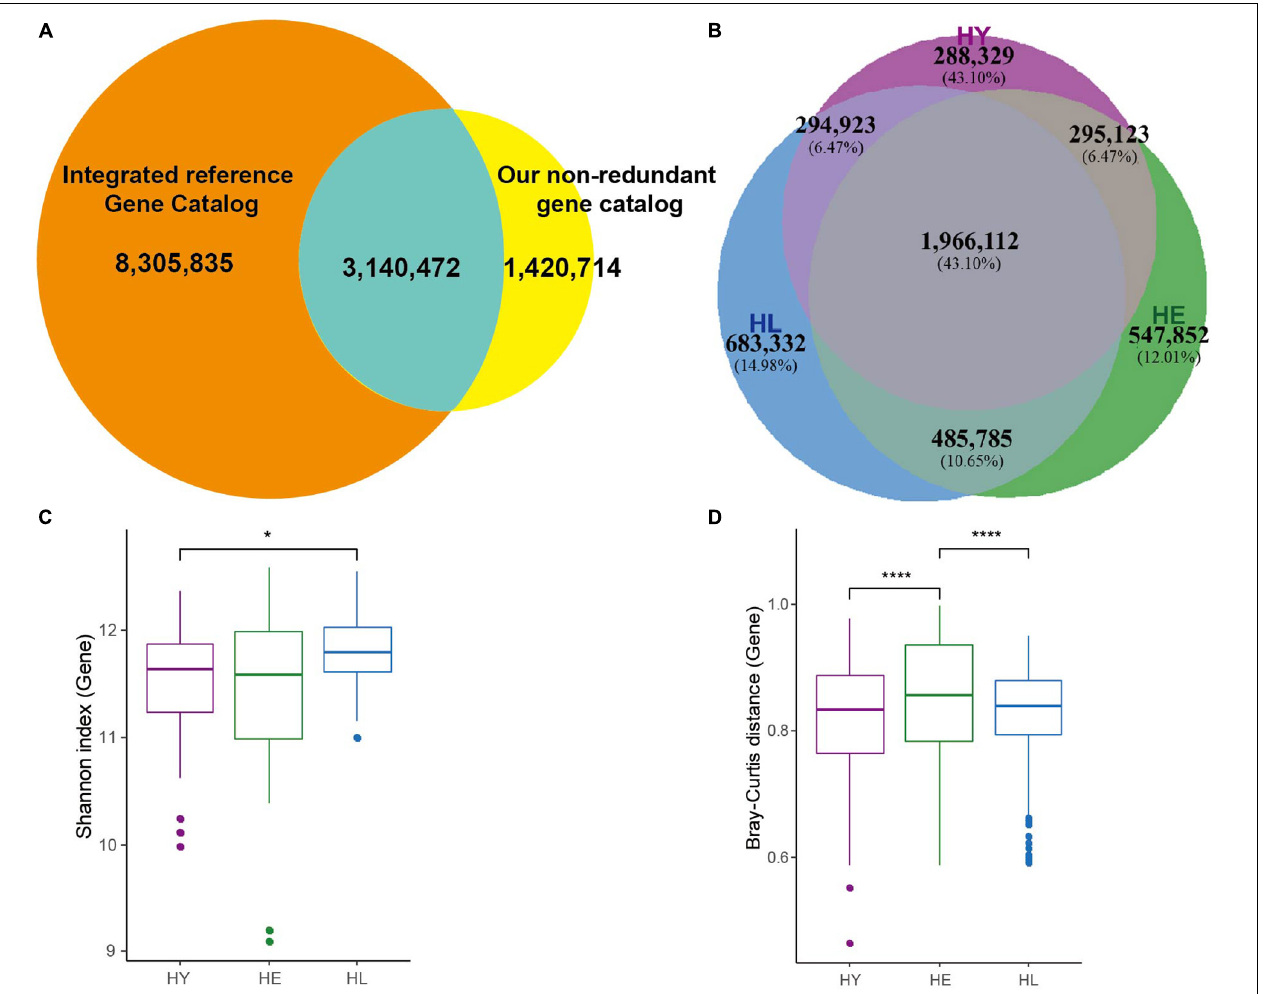
FIGURE 1 | Gut microbiome profile in three age groups. (A) Venn diagram of gut microbial genes shared between Integrated reference Gene Catalog (IGC) and our non-redundant genes. (B) Venn diagram of gut microbial genes shared between the three age groups. Boxplot of the distribution of gene Shannon diversity index (C) and the distribution of inter-individual Bray-Curtis distance (D) . Variation between different age groups was detected by Kruskal-Wallis followed by Dunn’s post hoc multiple-comparison test. Statistical significance symbols: *, P < 0.05; ****, P < 0.0001. HL, long-living people; HE, elderly people; HY, young